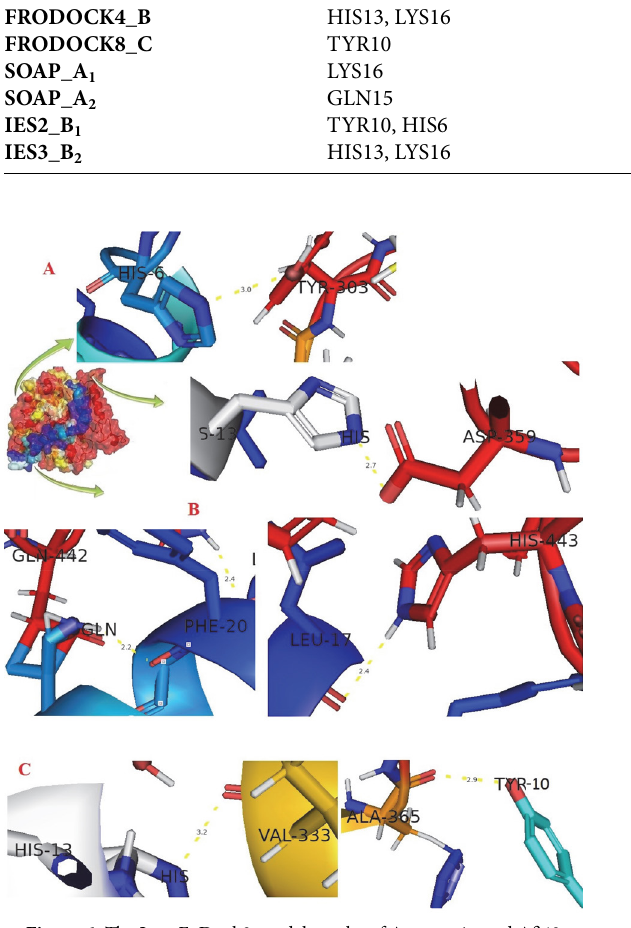
Figure 7. The SOAP_PP model results of Aggregatin and Aβ42 pep- tides. Binding modes of Aggregatin and Aβ 42 in surface representa- tions are shown. A.) Aggregatin(HIS445) interacts with GLY9, ARG447 with HIS6, LEU353 with GLY37 of Aβ42 with a lower en- ergy score. B.) Aggregatin(ARG447) interacts with TYR10 and HIS443 with VAL18 of Aβ 42. HIS6, GLY9 (of section A), and TYR10, and VAL18 (of section B) are in the N-terminal domain of the Aβ 1-42 peptide whereas GLY37 in section A is in the C-terminal domain of the Aβ 42